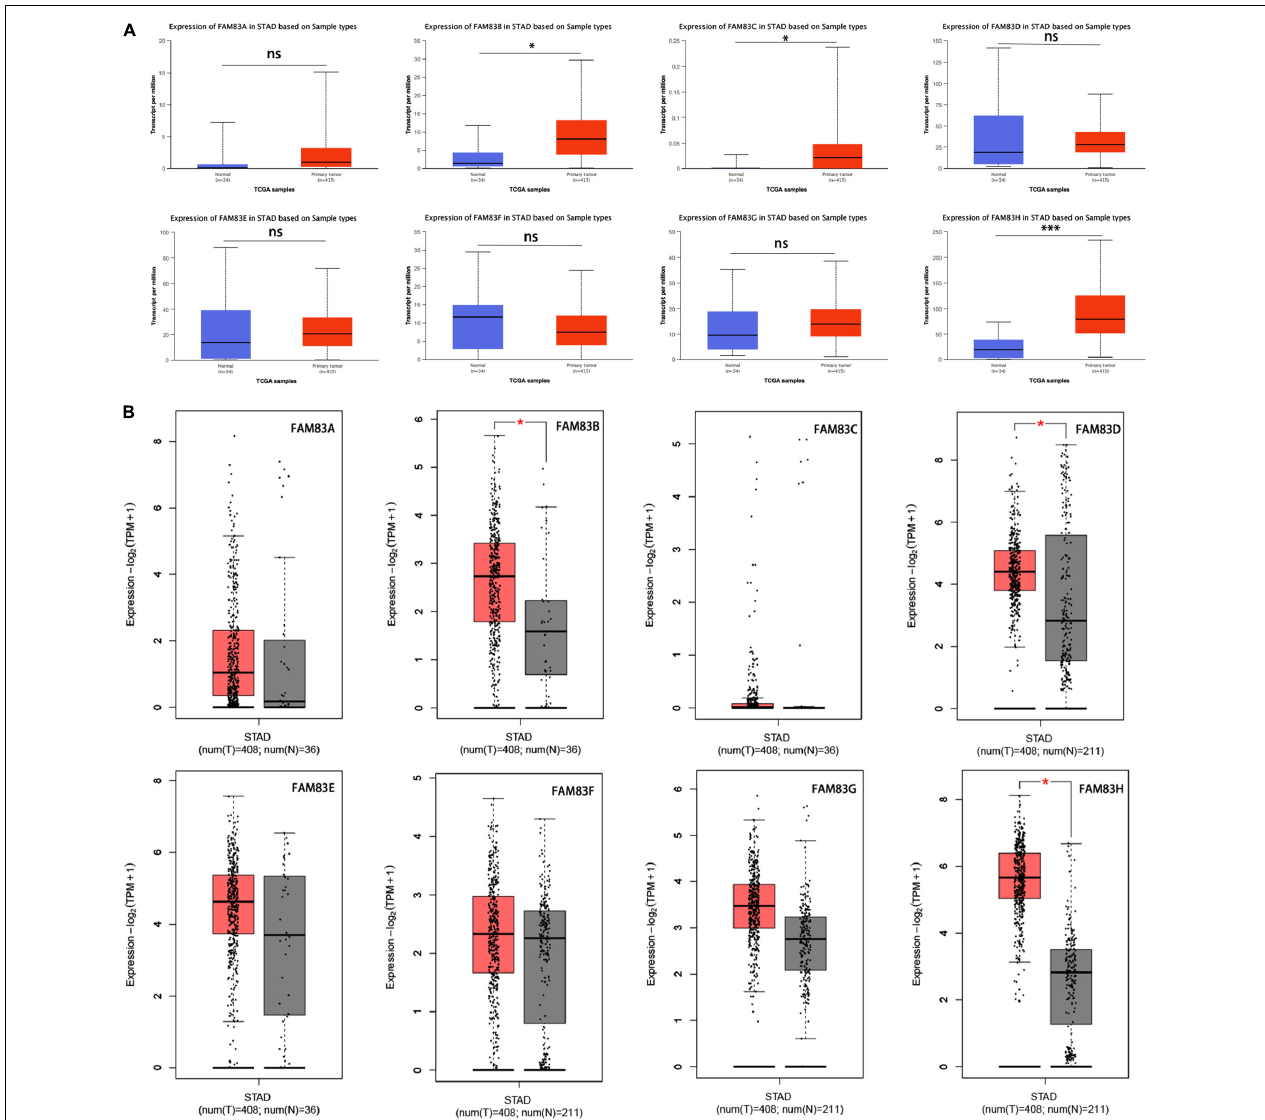
FIGURE 2 | (A) The mRNA expressions of FAM83B/C/H were found to be over-expressed in STAD tissues compared to normal samples in UALCAN. ∗∗∗ p < 0.001 and ∗ p < 0.05. (B) The mRNA expressions of FAM83B/D/H were discovered to be over-expressed in STAD tissues compared to normal stomach tissues in GEPIA2.0. Significance of difference estimated by Student’s t -test and analysis of variance (ANOVA). ∗ p <